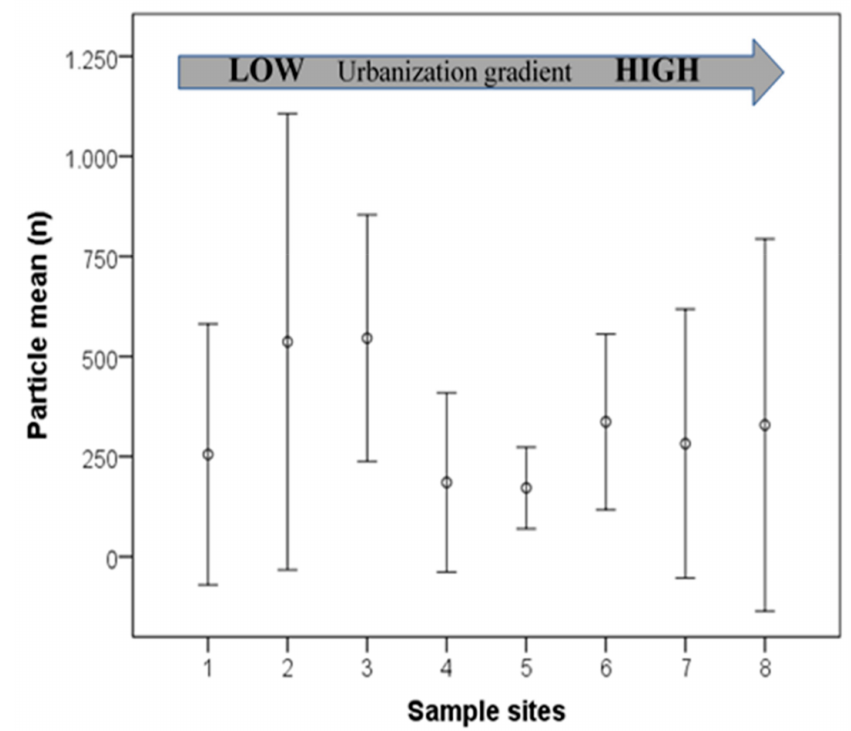
Figure 3. Mean particle concentration from two river water samples following the urbanization gradient of the Sinos River basin (low numbers = headwater sites; bars = standard